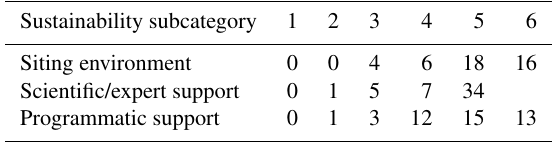
Table 6. Frequency of occurrence of the maturity matrix scores for the three subcategories (sitting environment, scientific/expert sup- port, programmatic support) of the main category, sustainability. Note that category six is not used in scientific/expert